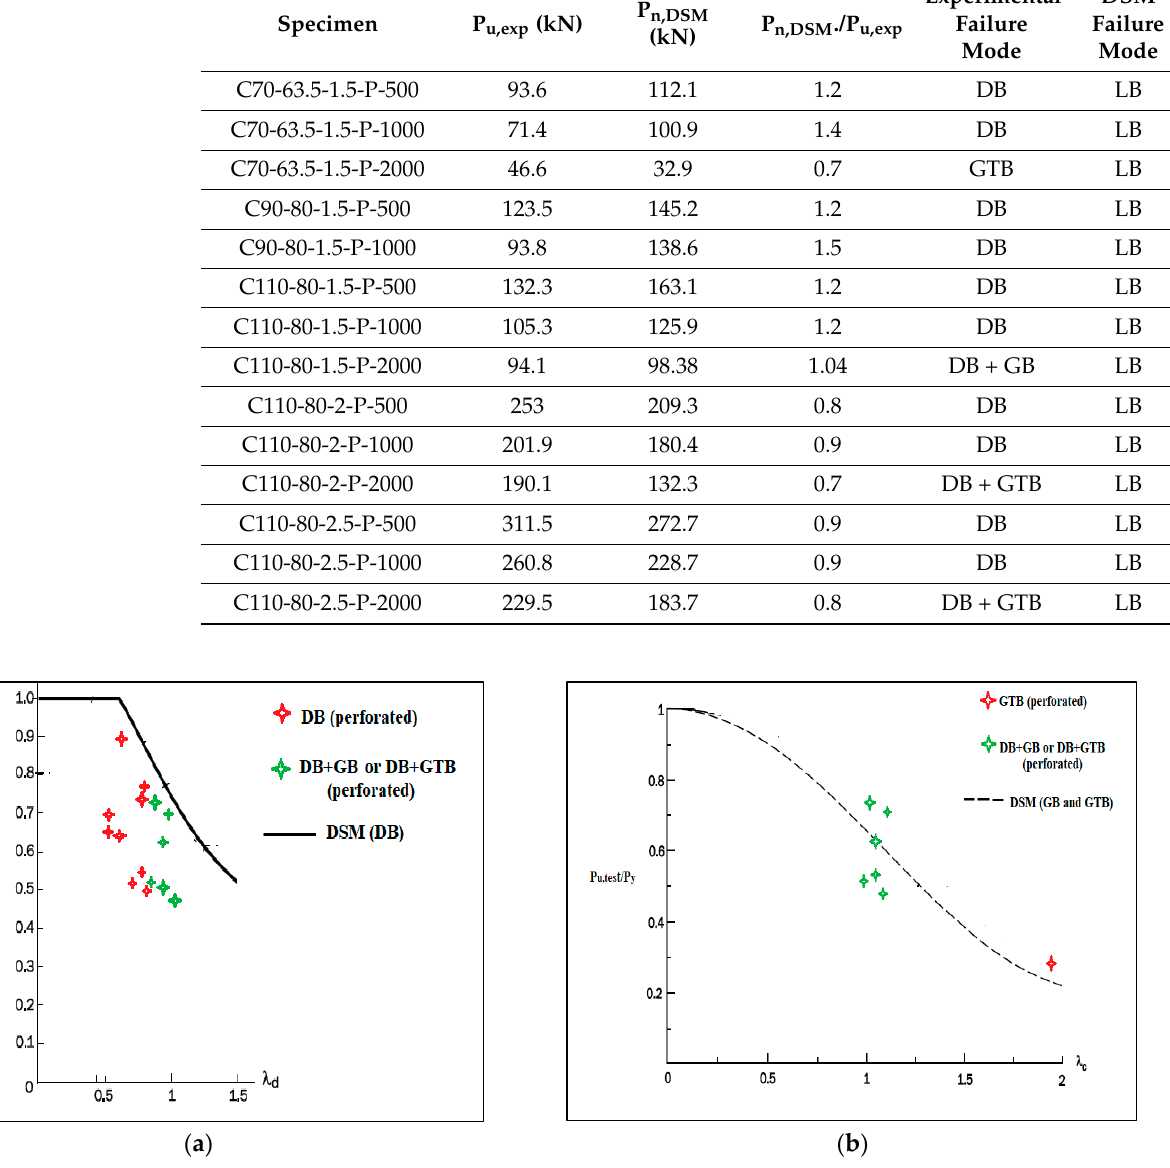
Figure 7. Comparison between the results of DSM and the results of the experimental test. ( a ) DSM distortional strength curve and experimental results; ( b ) DSM global strength curve and experimental results.